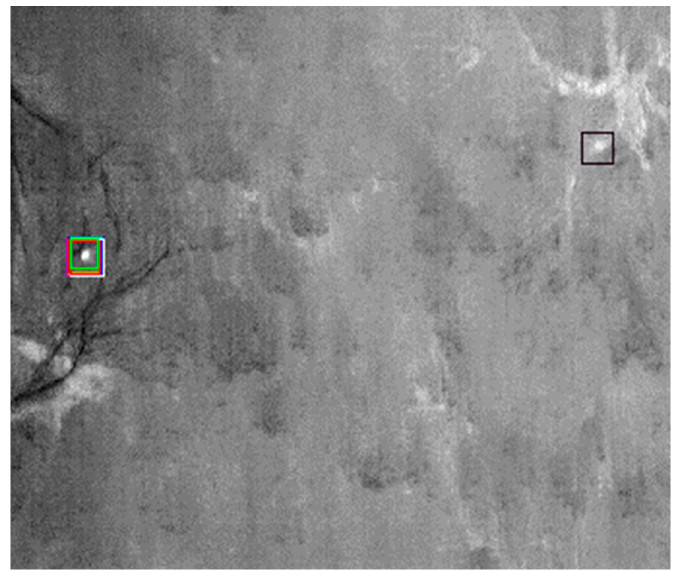
Figure 2. Two objects identified in a single frame as potential koalas. The object at the left of the frame is being tracked by multiple component detectors with relatively high confidence, while the object at the right is being tracked by just one detector with lower confidence. If confidence falls below the threshold level, tracking of the object will cease.